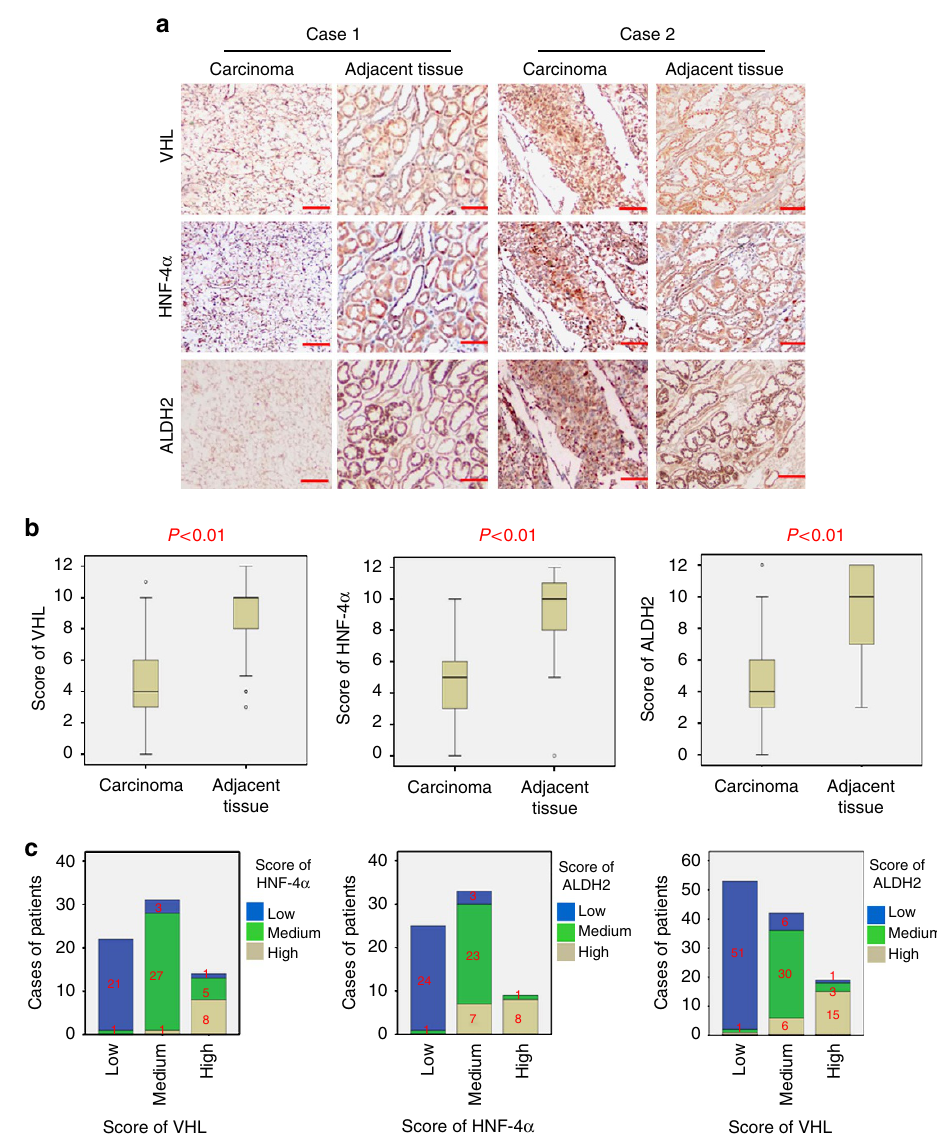
Figure 8 | Correlation of these proteins in ccRCC tissues. ( a ) Representative immunohistochemistry images of ccRCC samples for the low and high expressions of indicated proteins. The scale bar represents 100 m m. ( b ) VHL, HNF-4 a and ALDH2 expression scores are shown as box plots, with the horizontal lines representing the median; the bottom and top of the boxes representing the 25th and 75th percentiles, respectively; and the vertical bars representing the range of data. We compared renal clear cell carcinoma tissues with matched adjacent tissues ( n ¼ 114). Any outliers are marked with a circle. P value is calculated via t -test. ( c ) Correlation analysis of VHL, HNF-4 a and ALDH2 expression are calculated via Pearson’s w 2 test and all the P value are less than